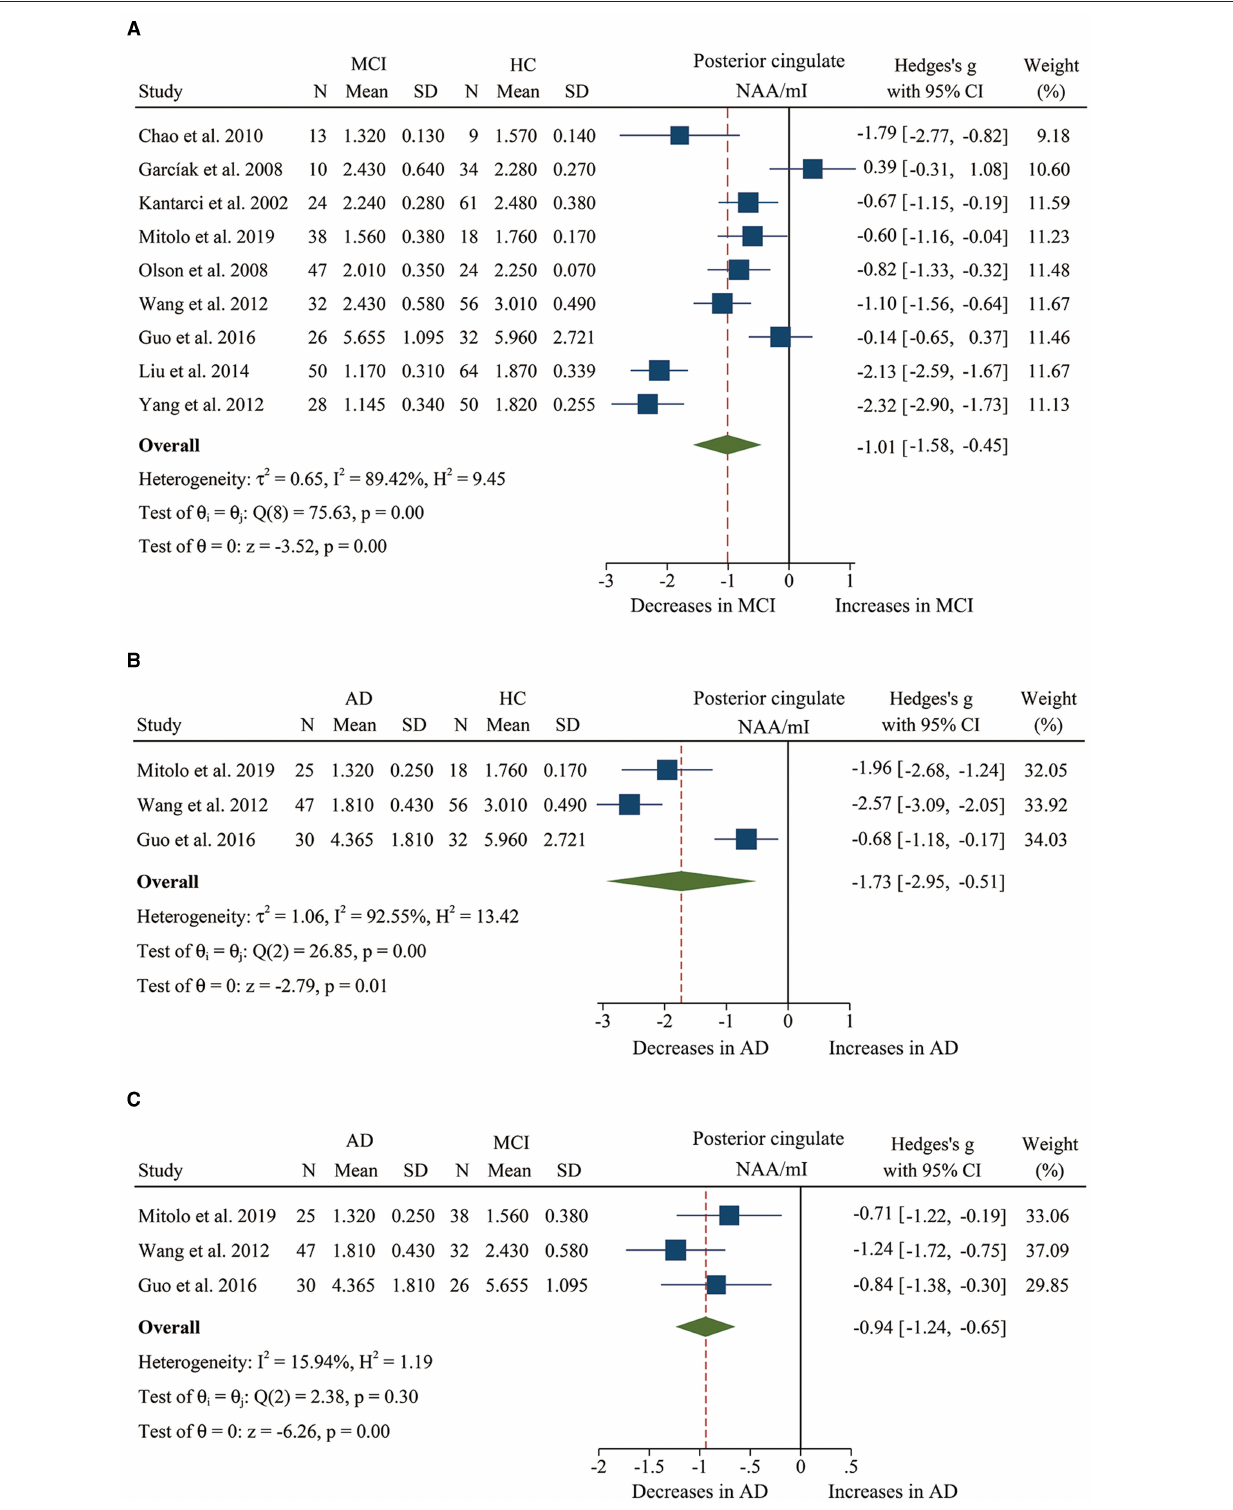
Frontiers in Aging Neuroscience |